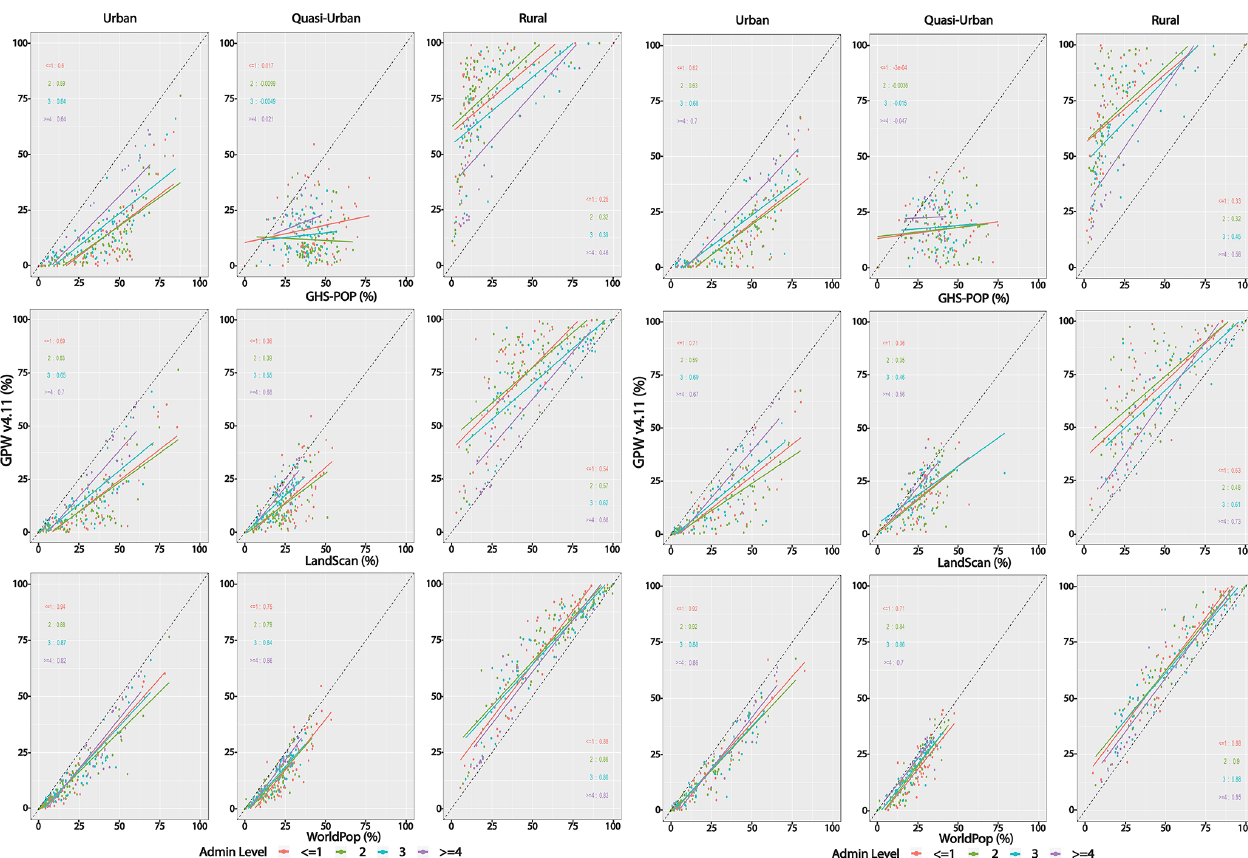
Figure B7. Comparison of population data sources by level of input unit in GPW, by urban–rural classes and urban-proxy data sets (GHS- BUILT). The left panel shows all land areas; the right panel shows only under 10m